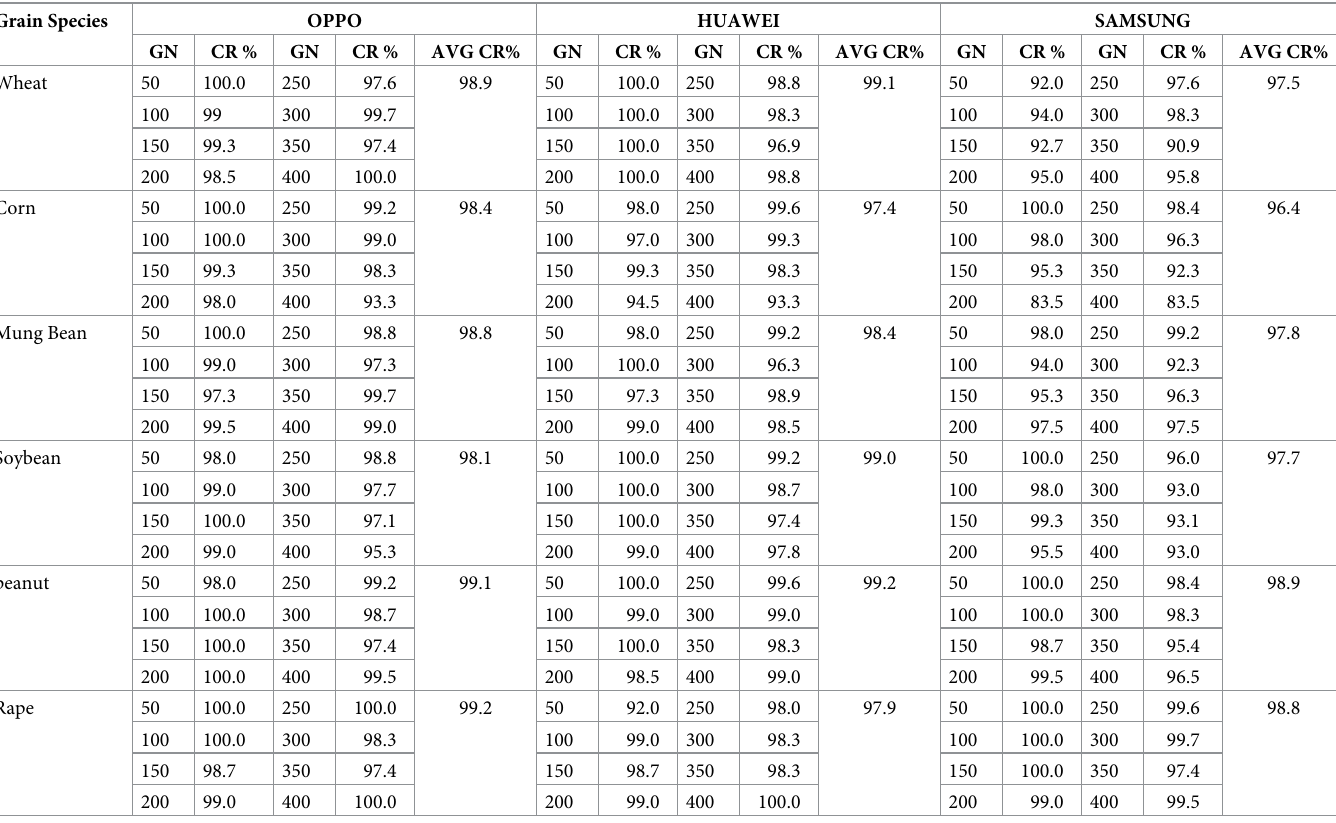
Table 3. Test results of different equipment for 6 kinds of